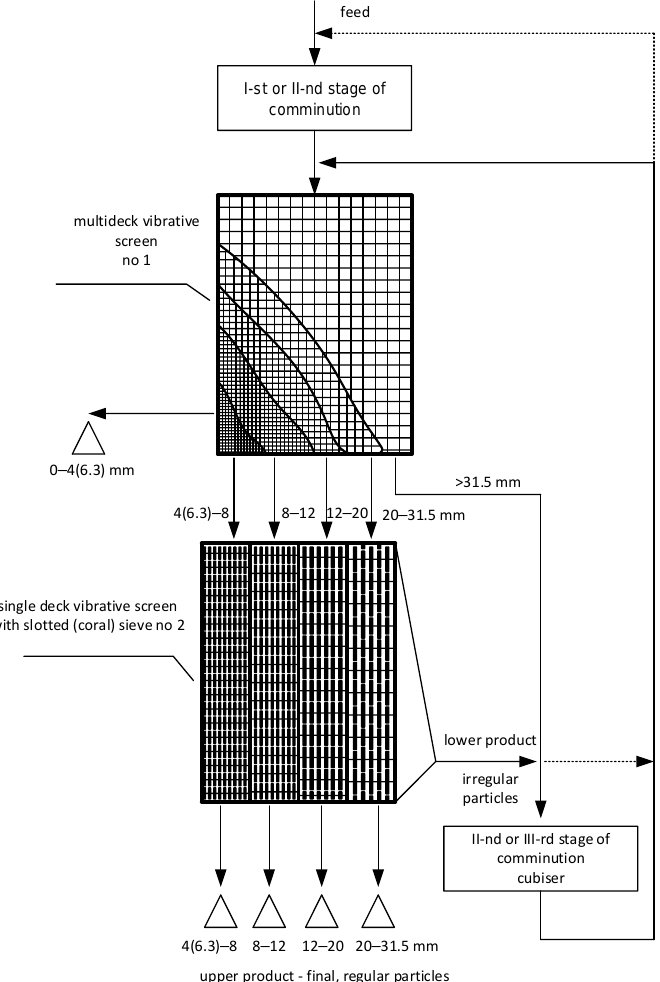
Figure 1. Idea of the aggregate production circuit with a closed recirculation for selective screening and crushing operations (Patent PL233689).